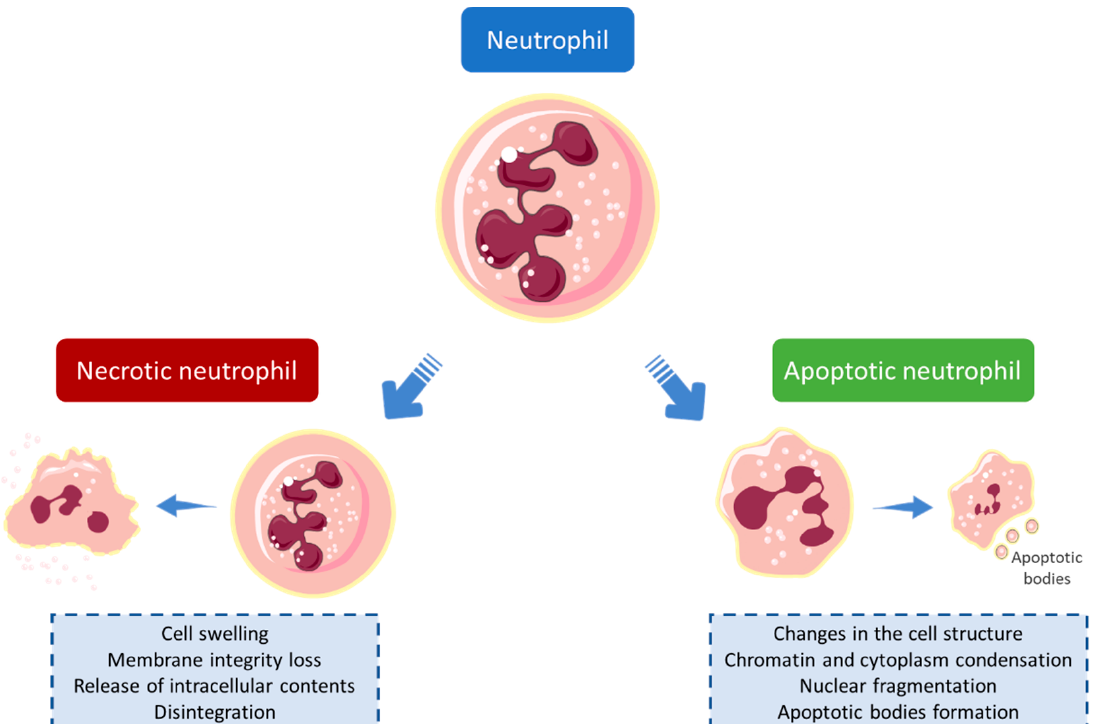
Figure 2. Mechanisms involved in cell death (apoptotic and necrotic pathways). During necrosis, the cell swells, which consequently leads to the loss of membrane integrity and the release of intracellular contents, and subsequently the disintegration of the cell. The apoptotic process is characterized by condensation of chromatin and cytoplasm, fragmentation of the cell nucleus, and formation of apoptotic bodies. In addition, changes in cell structure occur [13,15,16].